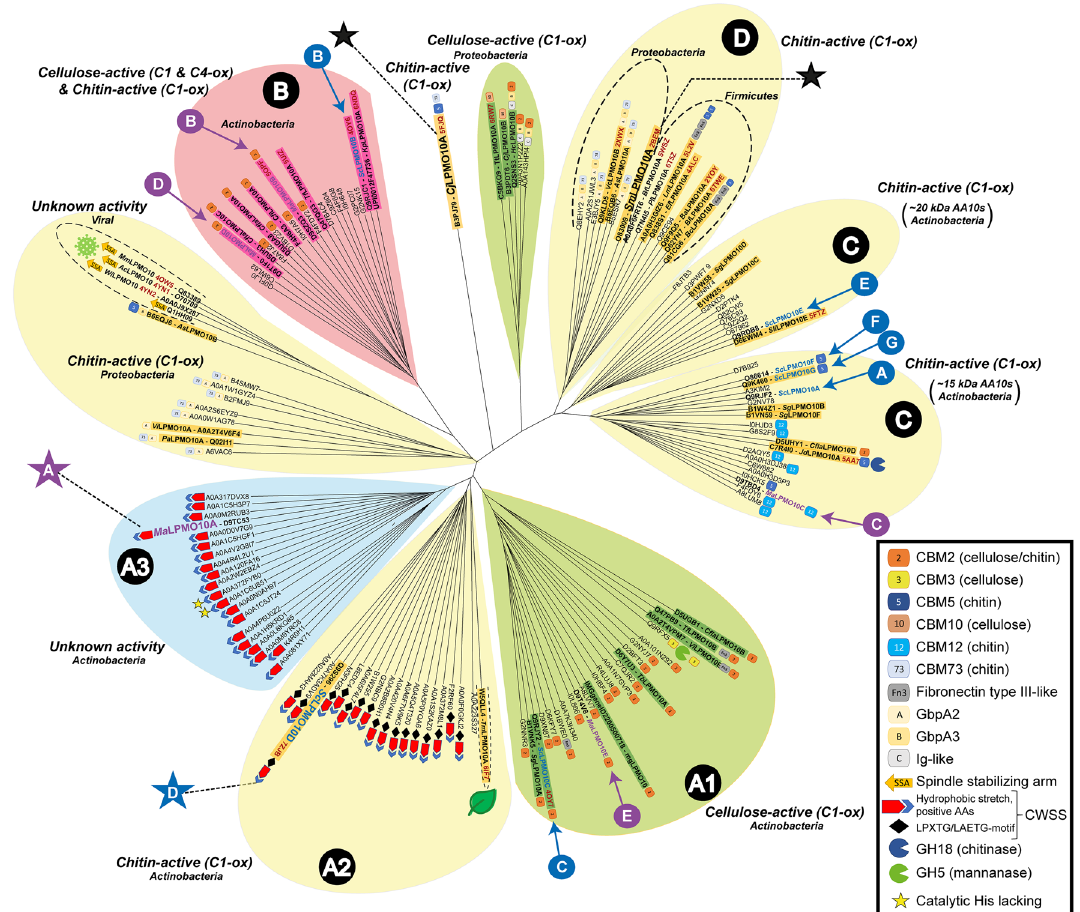
Figure 2. Phylogenetic tree built from 150 AA10 sequences. Highlighted enzymes have been experimentally characterized and are known to be strict C1 cellulose-oxidizers (green), show mixed C1/C4-oxidizing activity on cellulose and C1-oxidizing activity on chitin (pink) or known to oxidize the C1-carbon in chitin (yellow). Blue and purple labels indicate enzymes from S. coelicolor and M. aurantiaca, respectively . Ma LPMO10A, Sc LPMO10D, Cj LPMO10A and Sm LPMO10A, the four enzymes used in this study, are labelled by stars. The tree was built from catalytic domains only, but C-terminal domains are shown for each enzyme to highlight variation in domain architecture. The different domains found in the analyzed sequences include CBMs from families 2, 3, 5, 10, 12 and 73, fibronectin type III-like (Fn3) domains, immunoglobulin-like domains